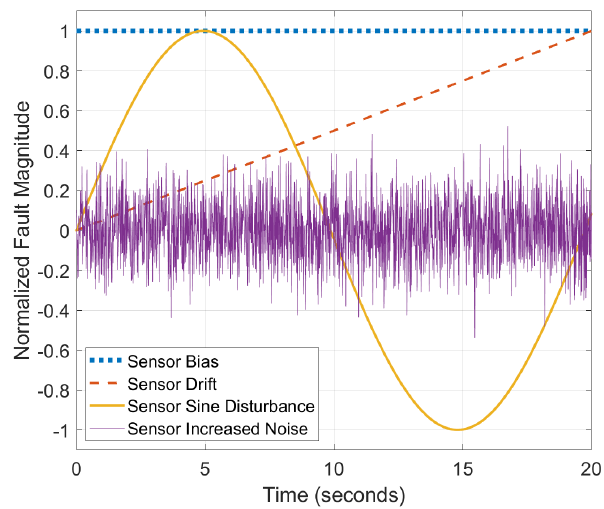
Figure 2. Normalized sample sensor fault scenarios over